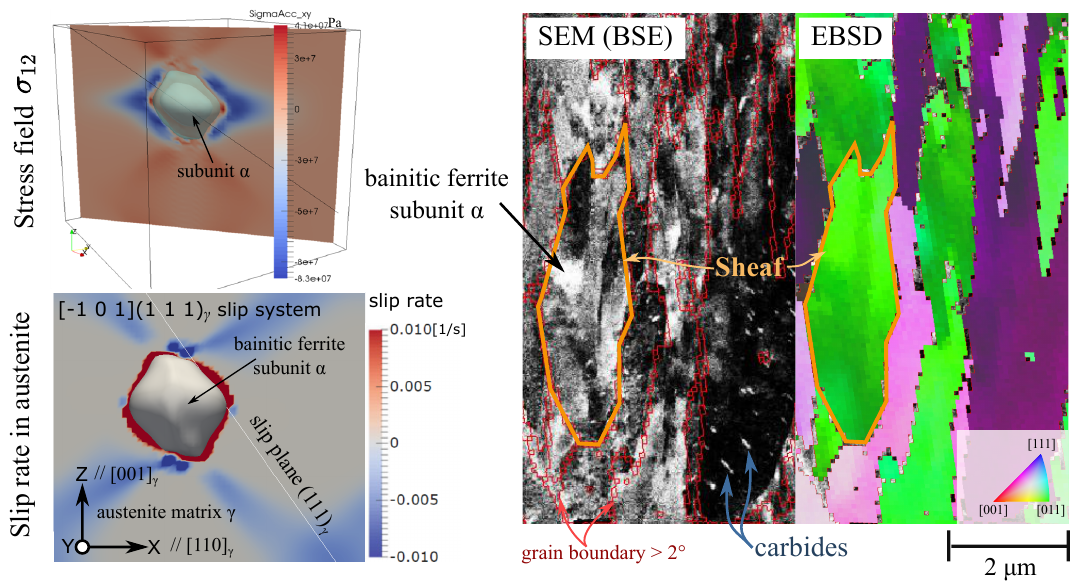
Figure 13. Growth of a bainitic ferrite subunit in the austenite matrix ( left ) and traces of subunits in SEM micrographs ( right